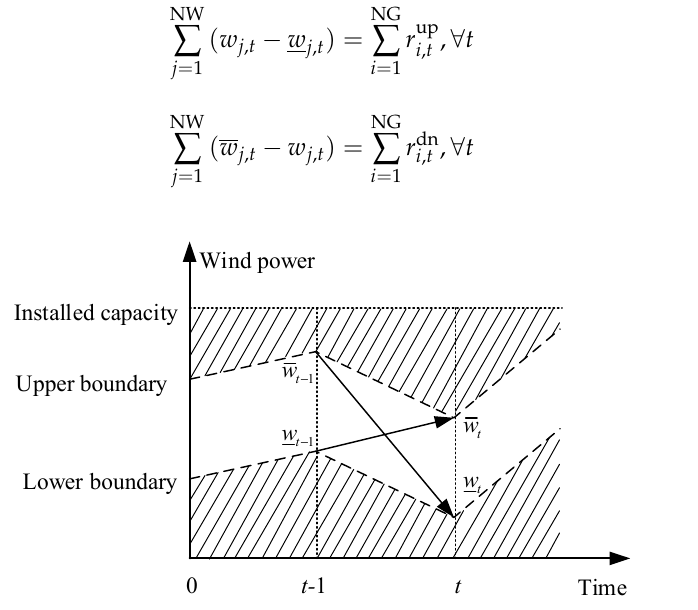
Figure 3. Schematic diagram of ramp constraints within confidence intervals.